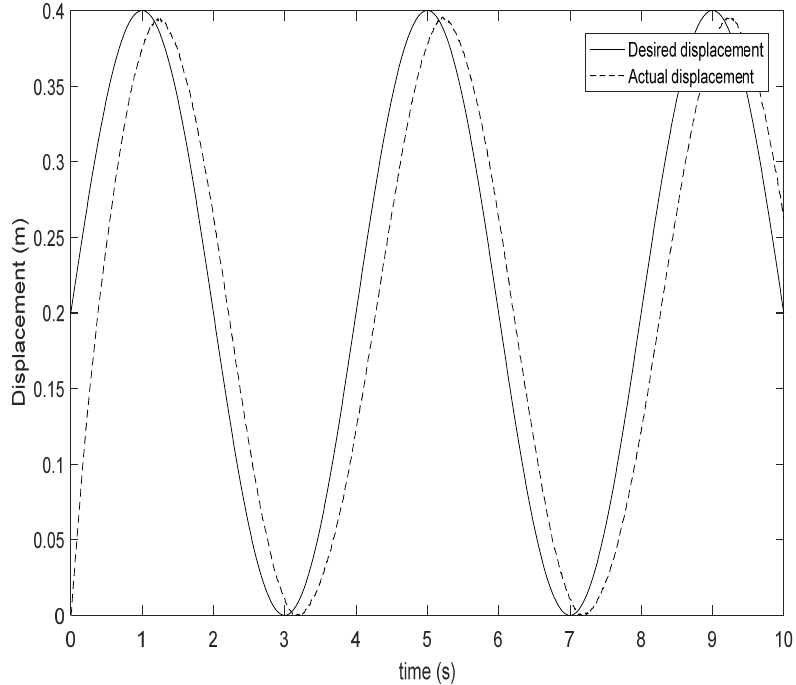
Figure 4. Displacement tracking trajectory of SMC algorithm using exponential reaching law.